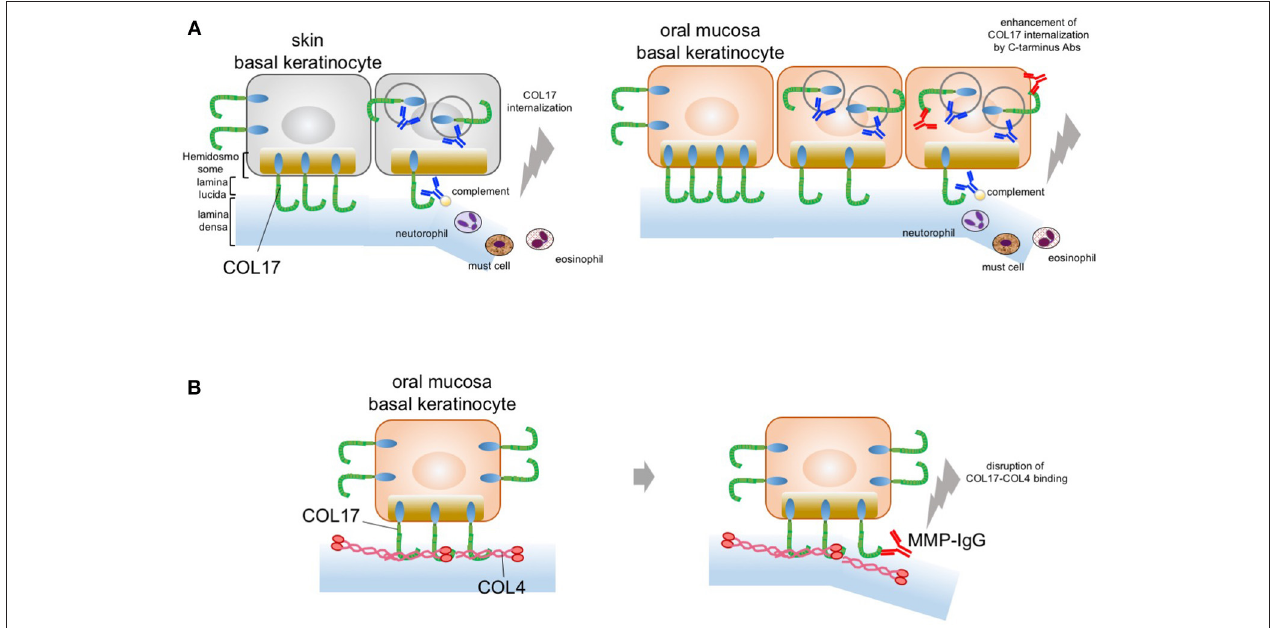
FIGURE 2 | Potential blistering mechanisms in oral mucosa. (A) The oral mucosal blistering in BP. COL17 molecules are located in both the hemidesmosomal and the non-hemidesmosomal plasma membranes. In the skin, autoantibodies targeting COL17-NC16A lead to the internalization of non-hemidesmosomal COL17 and result in COL17 depletion. The internalization and depletion of COL17 disturb the supply of hemidesmosomal COL17 and impair hemidesmosome formation. Eventually, intra-lamina lucida separation is caused by mechanical stress, complement activation, and/or inflammatory cell infiltration. This is mainly observed in the skin; therefore, the blisters predominantly occur in the skin (left panel). In the oral mucosa, autoantibodies targeting the C-terminus of COL17 enhance COL17 depletion induced by autoantibodies targeting COL17-NC16A. The blister formation in oral mucosa may be a result of the enhancement of COL17 depletion induced by autoantibodies targeting the C-terminus of COL17 in BP patients (right panel). (B) The predominant oral mucosal blistering in MMP. The direct binding of COL17 to COL4 is disrupted by IgG against the C-terminus in the oral mucosa. Autoantibodies in MMP targeting the C-terminus of COL17 inhibit the protein–protein interaction in the oral mucosa and reduce hemidesmosomal adhesion without the internalization of COL17.